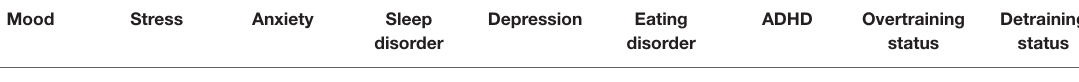
TABLE 2 | Brief mental health risk factors quantifying table for athletes with COVID-19.